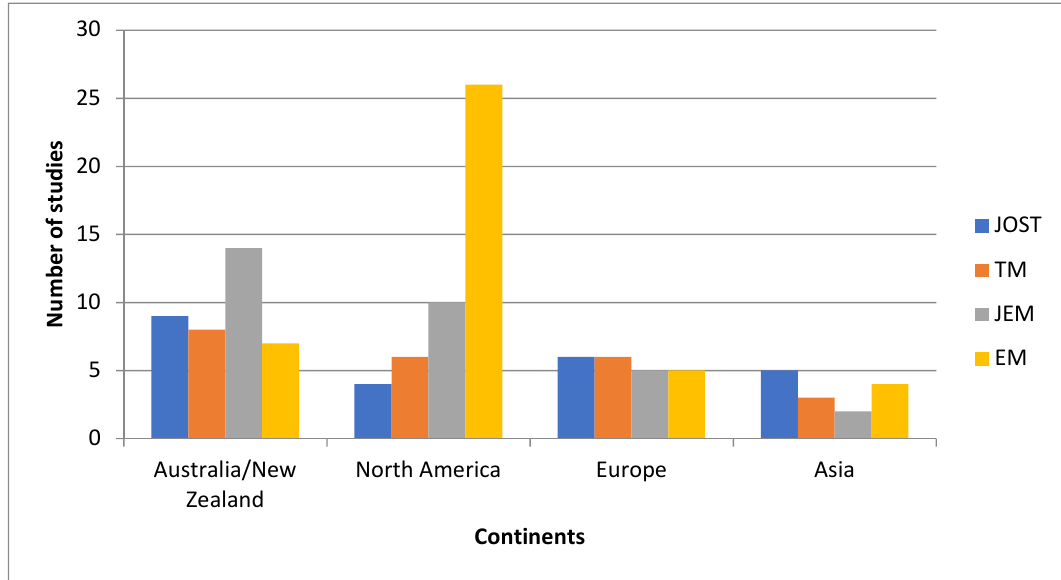
Figure 1. The number of recreational ecology papers by country (JOST, TM, JEM, EM, 1976–2017). excluding global subject-matter reviews. Table 2. Repeat first authors of recreational ecology papers by university (JOST, TM, JEM, EM, 1976–2017).